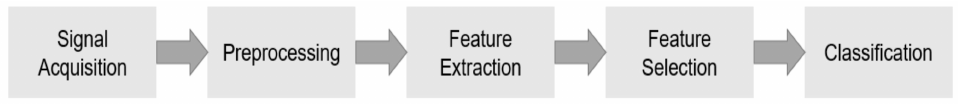
Figure 6. The track an fNIRS-BCI takes in order to receive useable data for an output and the order we will be following to understand the fNIRS-BCI process.